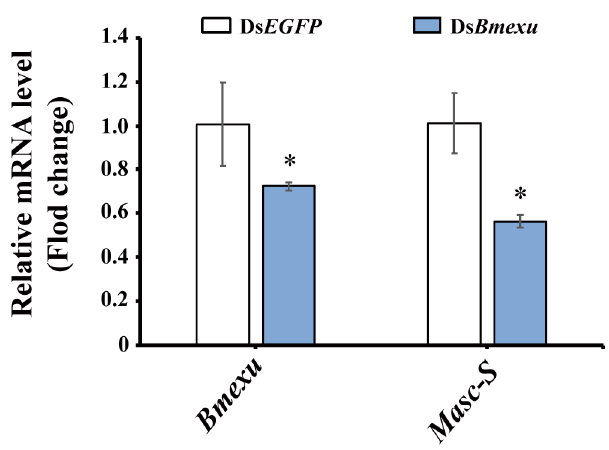
Figure 6. Expression level of Masc-S was down-regulated using dsRNA of Bmexu in the silkworm. The asterisk above the standard error bars indicates significant differences (* 0.01 < p < 0.05).